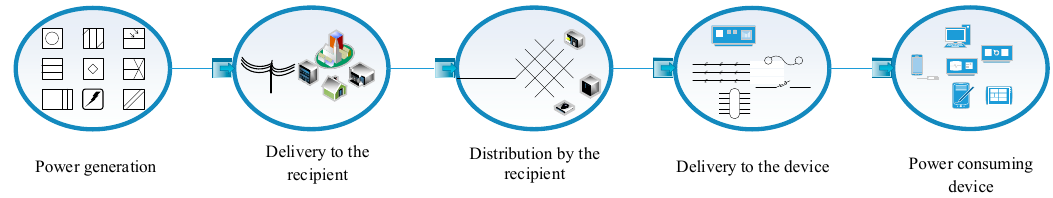
Figure 3. Physical stages of power.